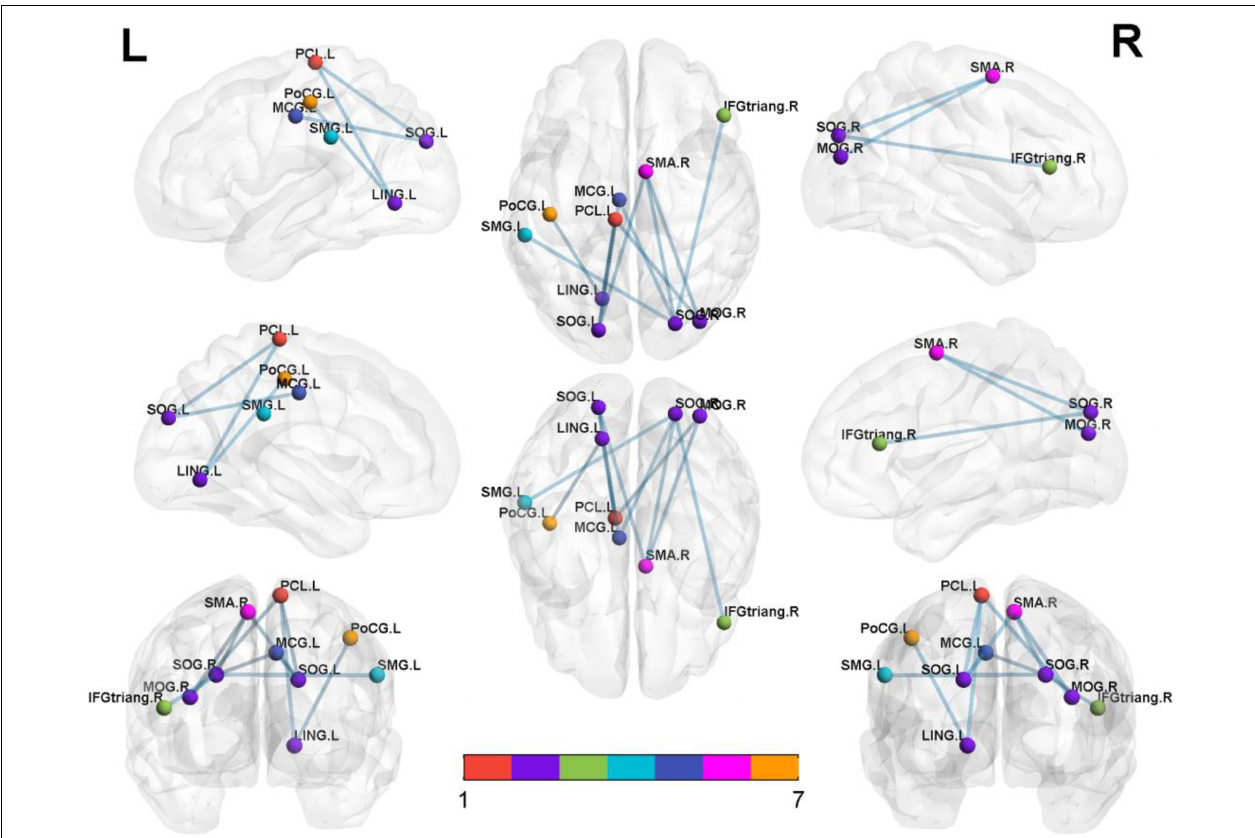
FIGURE 2 | Significantly altered nodal centralities of the brain functional connectome in patients with iRBD, compared with HCs ( P < 0.01, FDR-corrected). These connections formed a single connected network with 14 nodes and 27 connections ( P < 0.05, corrected by NBS). To facilitate differentiation, different brain regions were indicated by different colors. Lines represent decreased functional connectivity strength in patients with iRBD. Details are listed in Table 3 . MCG, middle cingulum gyrus; LING, lingual gyrus; SOG, superior occipital gyrus; MOG, middle occipital gyrus; PoCG, postcentral gyrus; SMG, supramarginal gyrus; IFG-triang, inferior frontal triangular gyrus; PCL, central paracentral lobule; SMA, superior motor area; Precg, precentral gyrus; REC, rectus gyrus; ROL, Rolandic operculum; STG, superior temporal